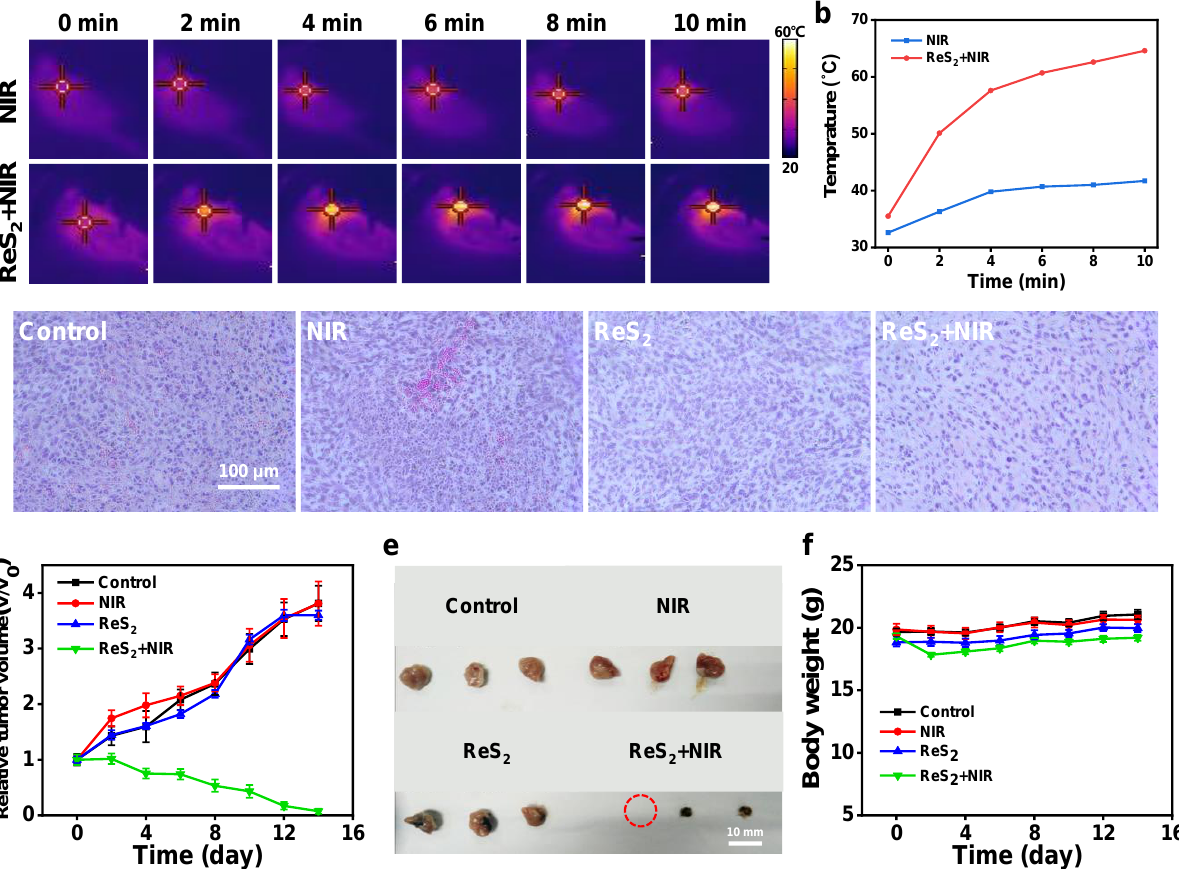
Figure 4. In vivo photothermal therapy. ( a ) Infrared thermal images of tumor-bearing mice injected with PBS and PEG-ReS 2 , respectively. The power density of the 808 nm laser was 0.5 W/cm 2 , and the irradiation time was 10 min. ( b ) The temperature curves at the tumor site according to Figure 4a. ( c ) Representative images of the H&E-stained tumor slices from four experimental groups one day after PTT treatment. ( d ) After PTT, the relative tumor volume of tumor-bearing mice was measured in the four experimental groups (8 mice in each group) every two days. ( e ) At day 14, tumors were obtained from three randomly selected mice from each group for comparison. Tumors in the ReS 2 + NIR group were ablated, while tumors in the other groups were still large in size. ( f ) The body weight of the tumor-bearing mice from four experimental groups was measured.